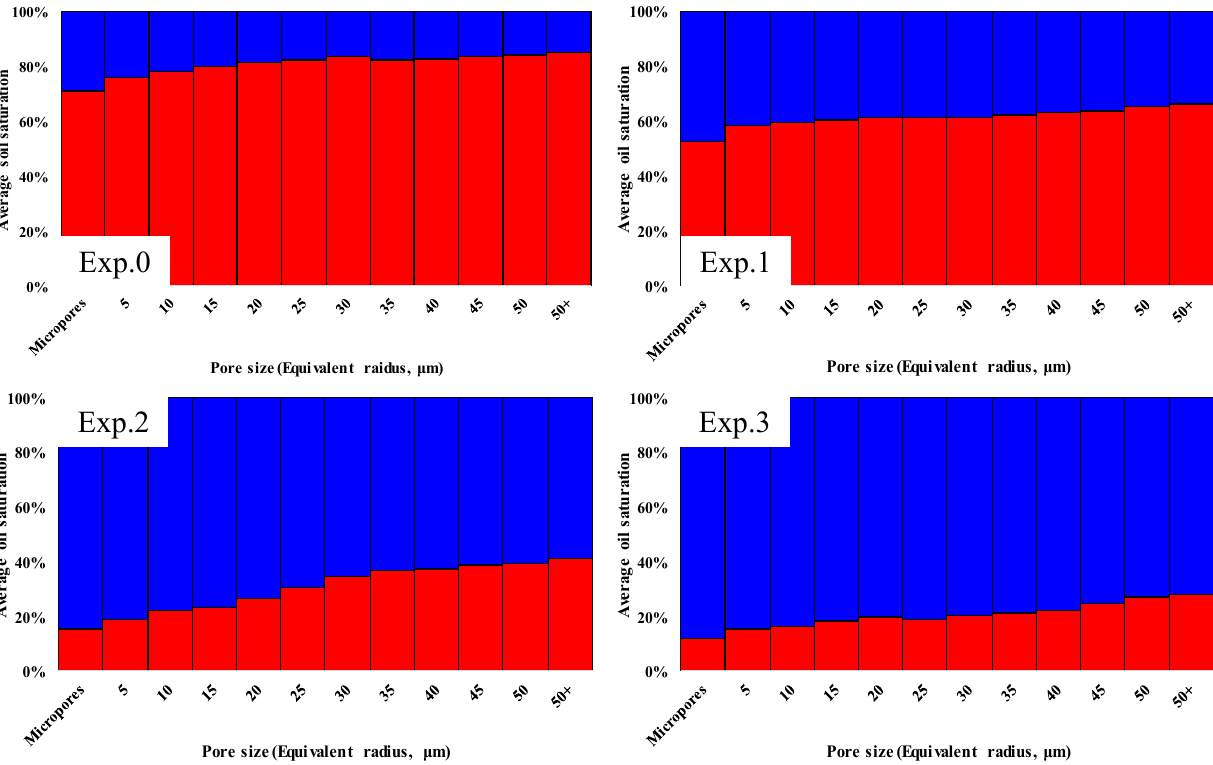
Figure 16. Bar graphs representing the pore occupancy in different stages. Each colored bar represents the average oil (red) or water (blue) proportion of the pores with equivalent radius in the bin range.